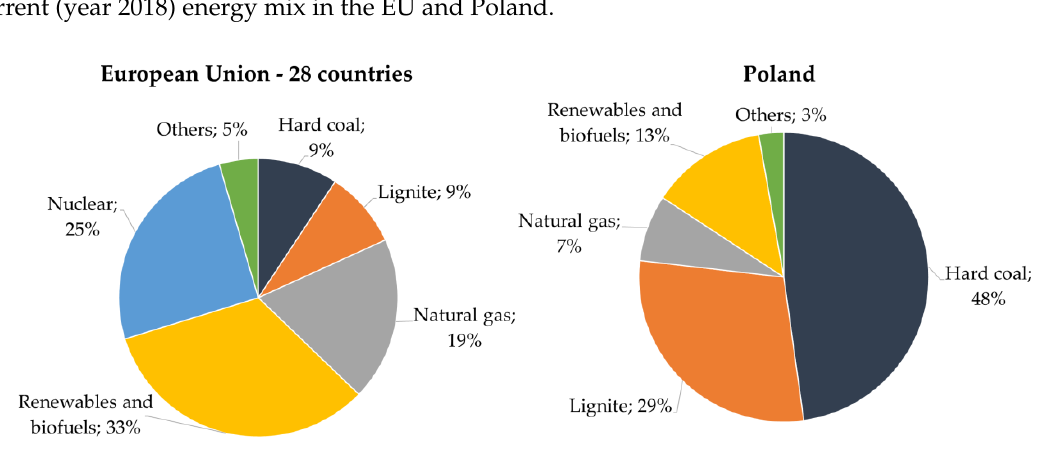
Figure 2. Structure of electricity generation in the EU and in Poland (year 2018).